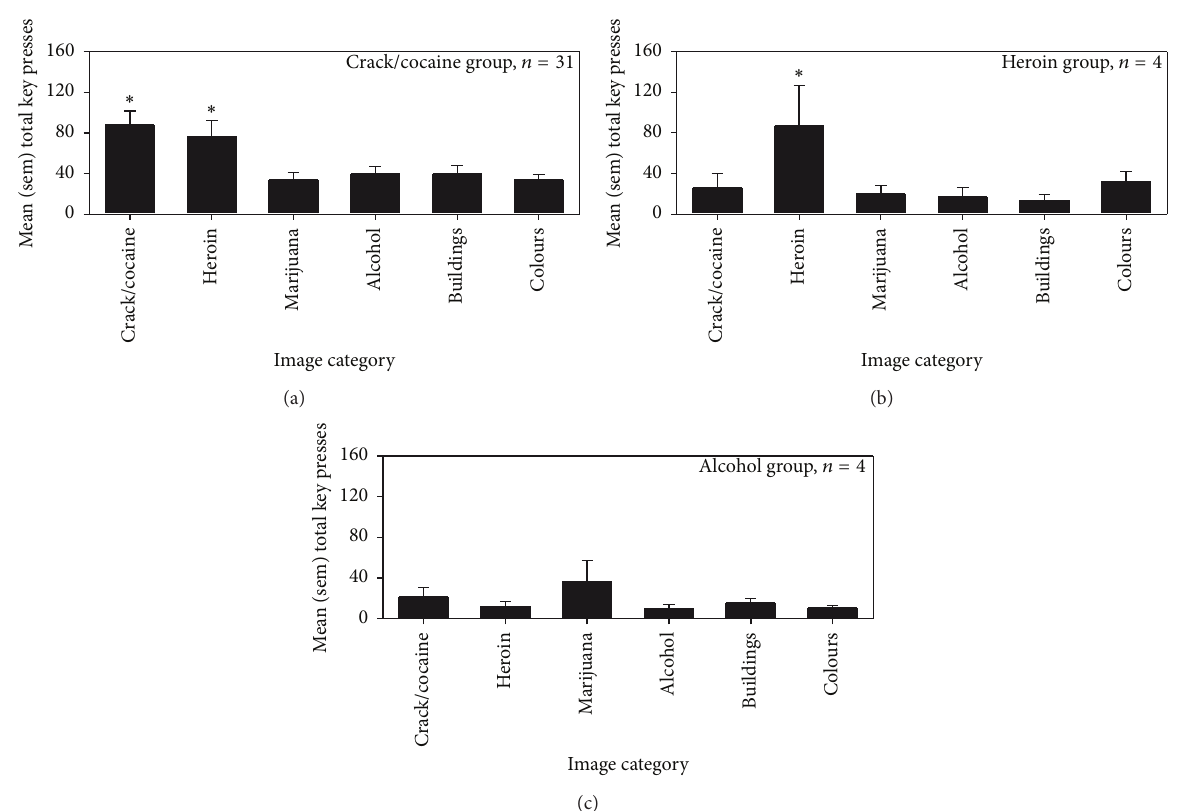
[ 𝑡(30) = 3.85 , 𝑃 = 0.0006 ]; heroin (Figure 4(b)) and alcohol (Figure 4(c)) groups: trend in the same direction) or by preferred route of administration (Figure 4(d): non- intravenous group [ 𝑡(17) = −3.12 , 𝑃 = 0.006 ]; Figure 4(e): intravenous group [ 𝑊 = 74.00 , 𝑍 = 2.90 , 𝑃 = 0.001 ]; (Figure 4(c)) oral group: trend in the same direction). Thus, overall, the IAT D scores were